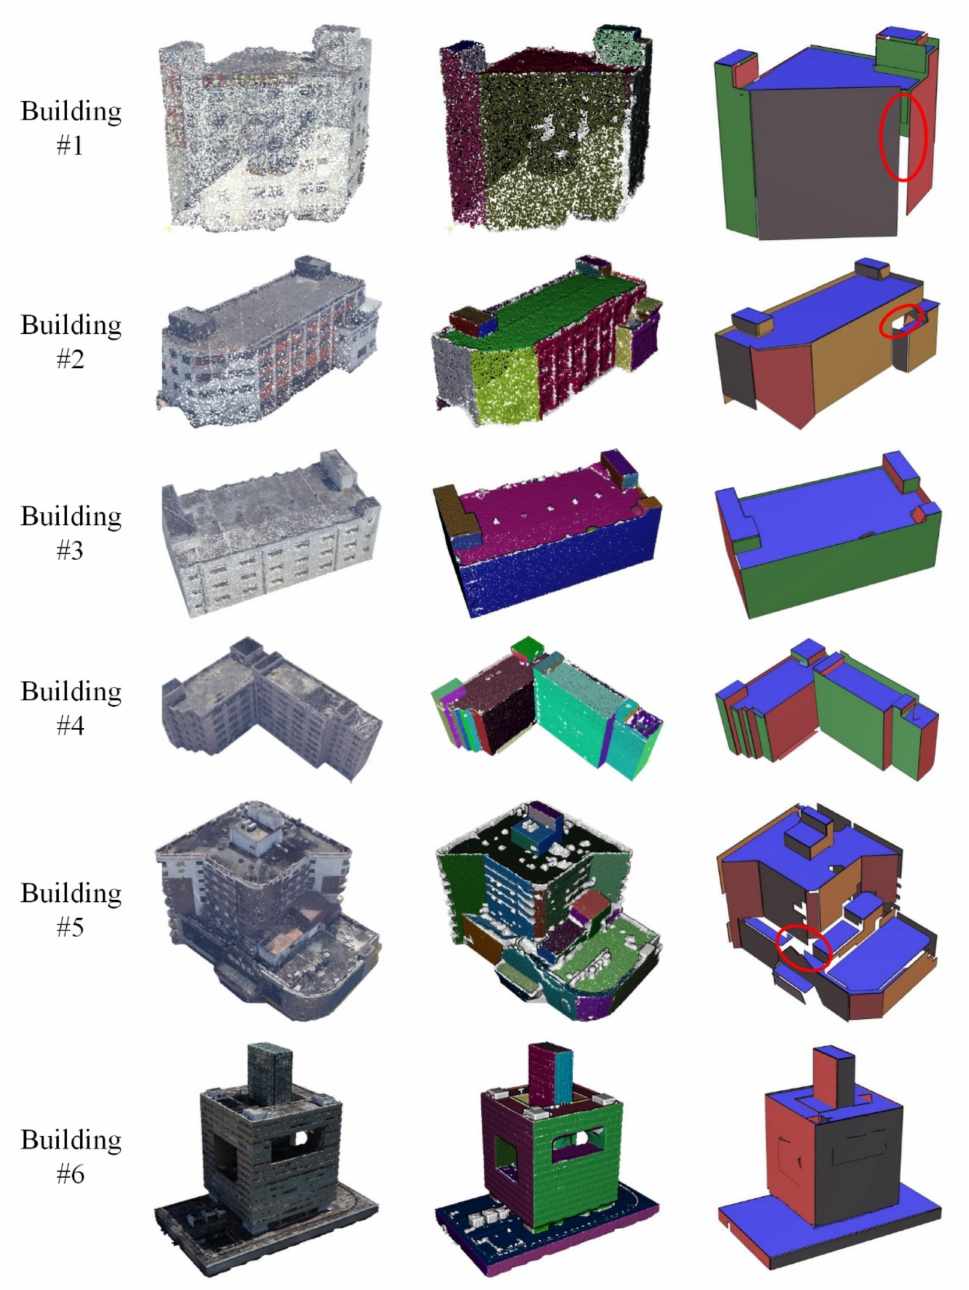
Figure 6. Photogrammetric point clouds used in the experiments. The row numbers correspond to the building IDs. From left to right, the columns show the original point clouds, the segmented planar primitives, and the extracted outer boundaries of each